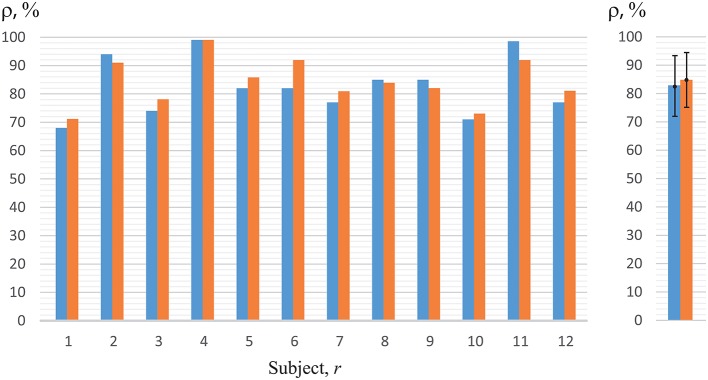
Recognition accuracy for all of the 12 subjects. The left-hand blue columns represent accuracy for each subject, using ANN trained on his/her own EEG (h = r) obtained in the first set of experiments (with key pressing). The right-hand orange columns show accuracy for the second set of experiments (without key pressing). The right panel represents the data averaged over all subjects under study.